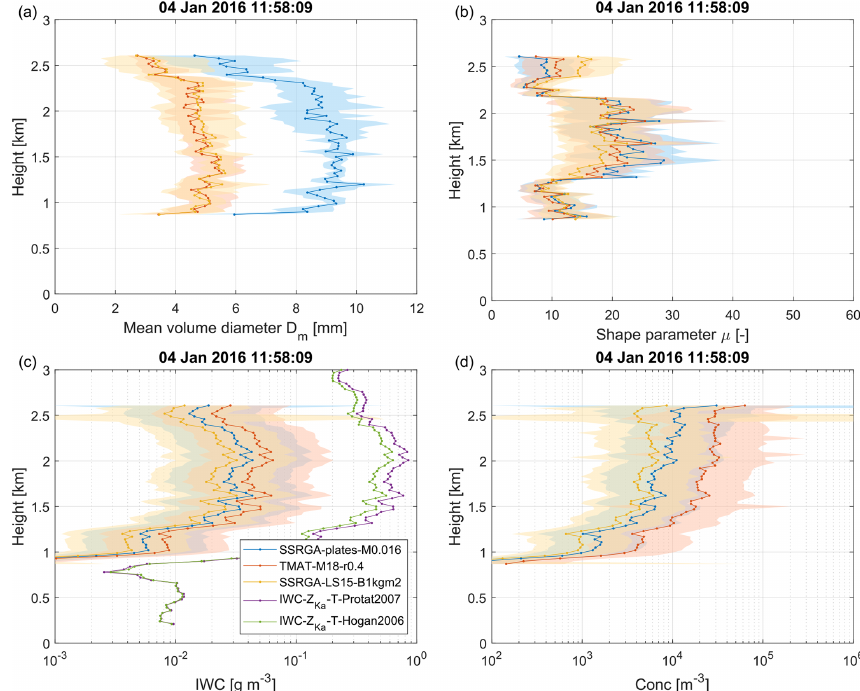
Figure 11. Comparison of (a) D m , (b) µ , (c) IWC and (d) n i profiles at 11:58:09UTC retrieved with the most probable EM-MIC models identified in Sect. 4.4. Colored shadings show the corresponding uncertainties obtained via Monte Carlo propagation as described in the retrieval